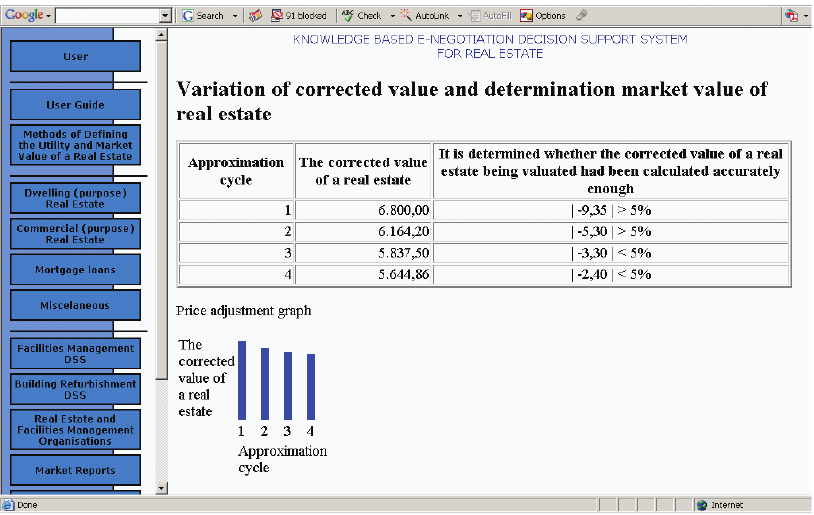
Figure 3. calculation of market value: presentation of market value’s calculations in numerical and graphic